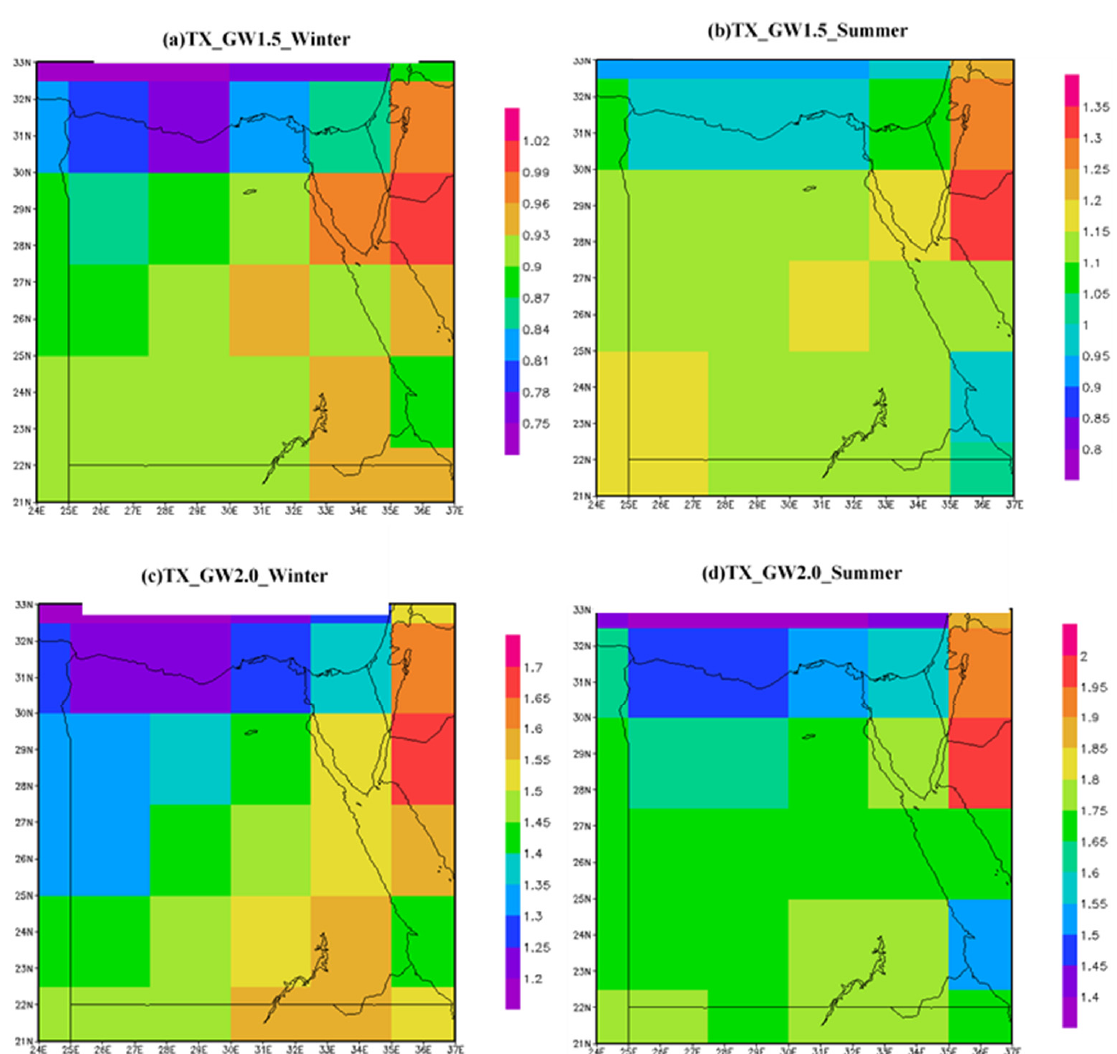
Figure 3. The seasonal absolute difference of maximum temperature for, ( a ) winter (TX) for GW1.5, ( b ) summer TX at GW1.5, ( c ) winter (TX) at GW2.0, and ( d ) summer TX at GW2.0.